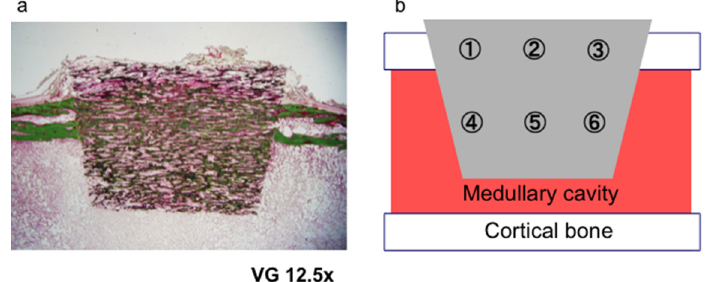
Figure 11. Sites used for the analysis of new bone formation in the cortical and medullary areas of the implanted UDPHAp block ( a ). The bone-occupied area inside UDPHAp was calculated at three fields (100× magnification) for both cortical bone regions (1–3) and the intramedullary (4–6) in each one section ( b